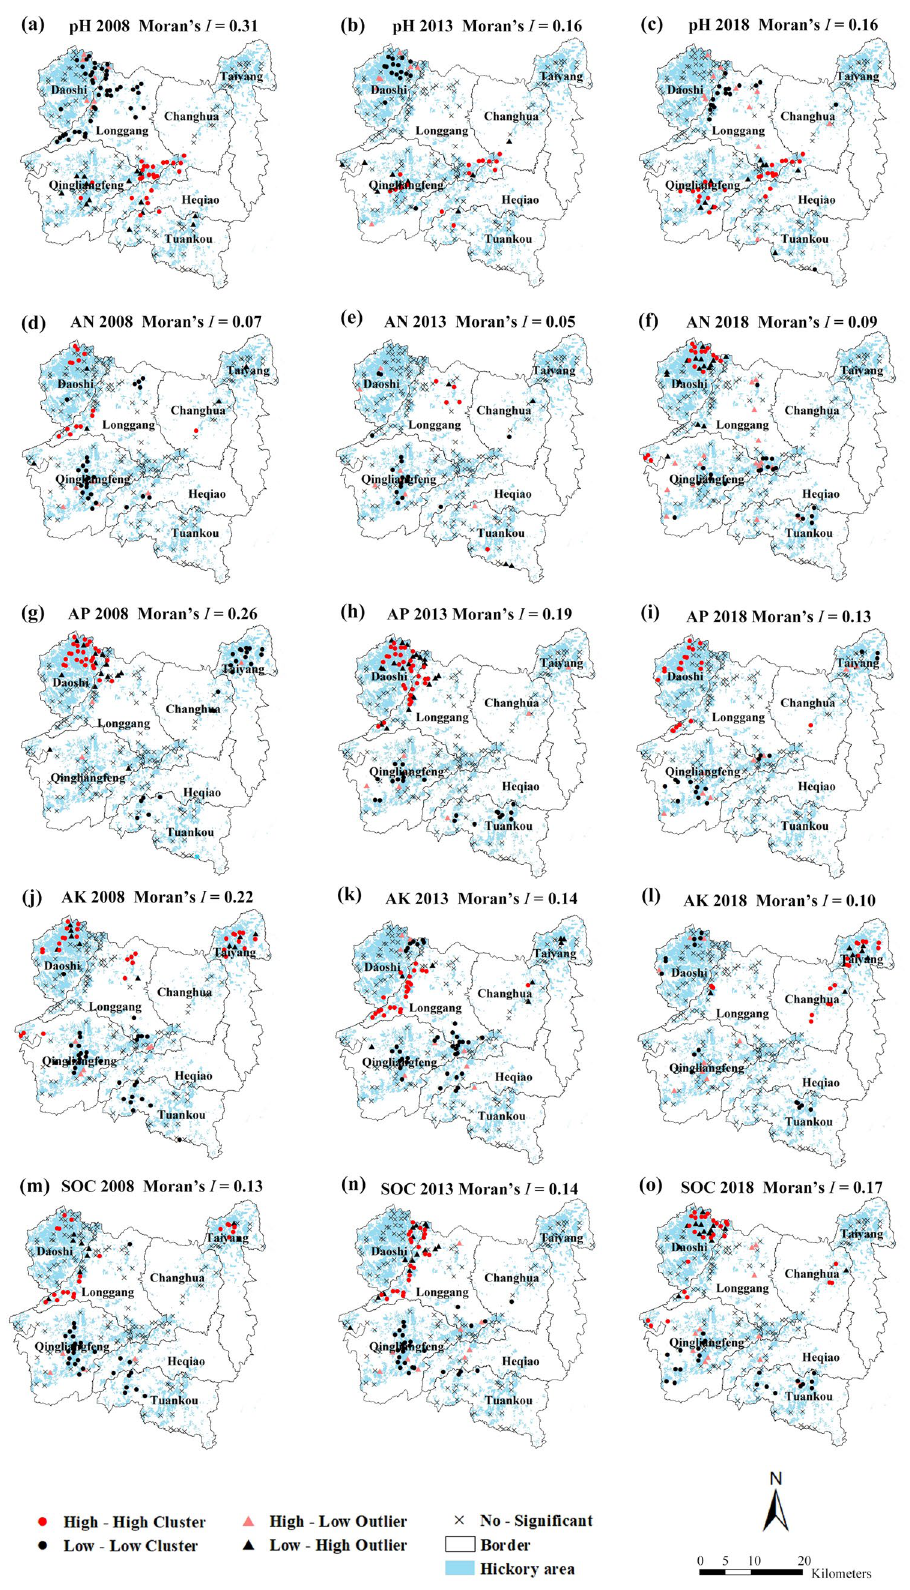
Figure 2. Local indicators of spatial association (LISA) maps of soil properties in Chinese hickory plantation regions. AN available nitrogen, AP available phosphorus, AK available potassium, SOC soil organic carbon. The maps were created in ArcGIS desktop